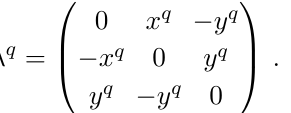
D /TeV on the couplings of the diquarks D